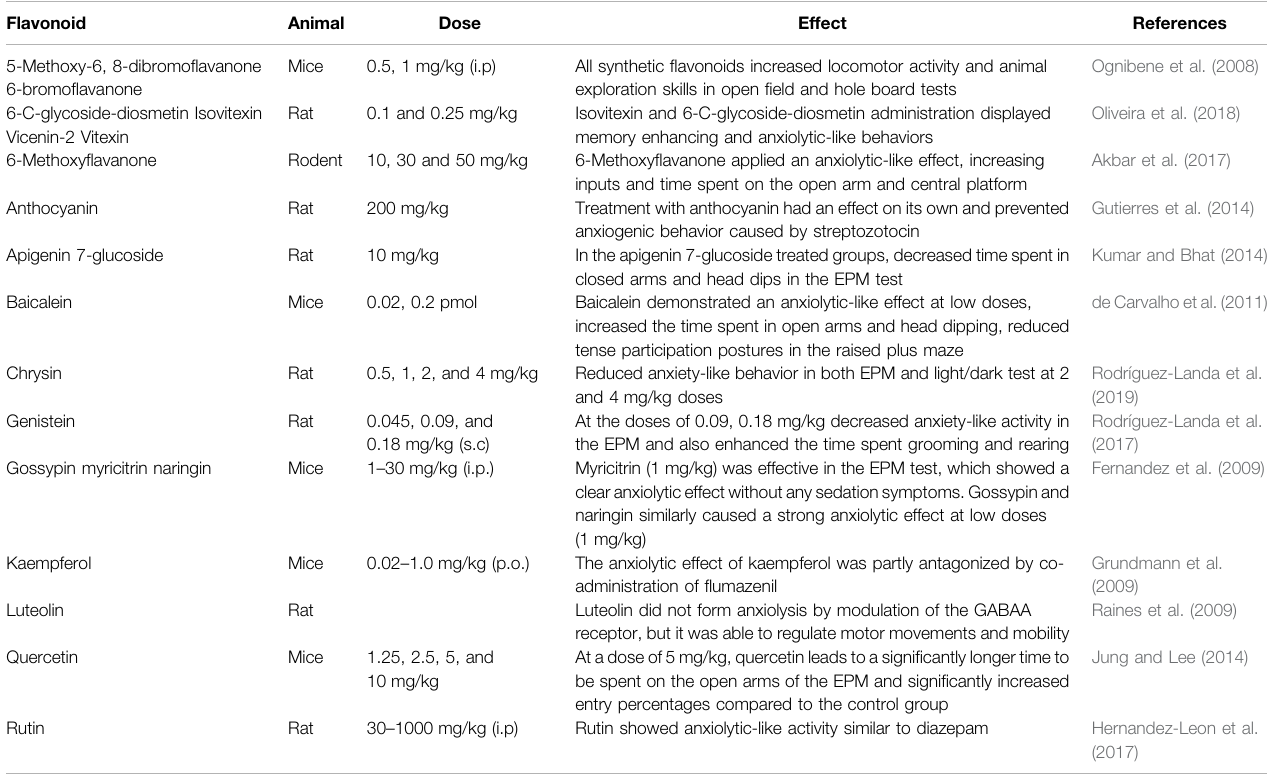
TABLE 2 | The anxiolytic effects of different fl avonoids.